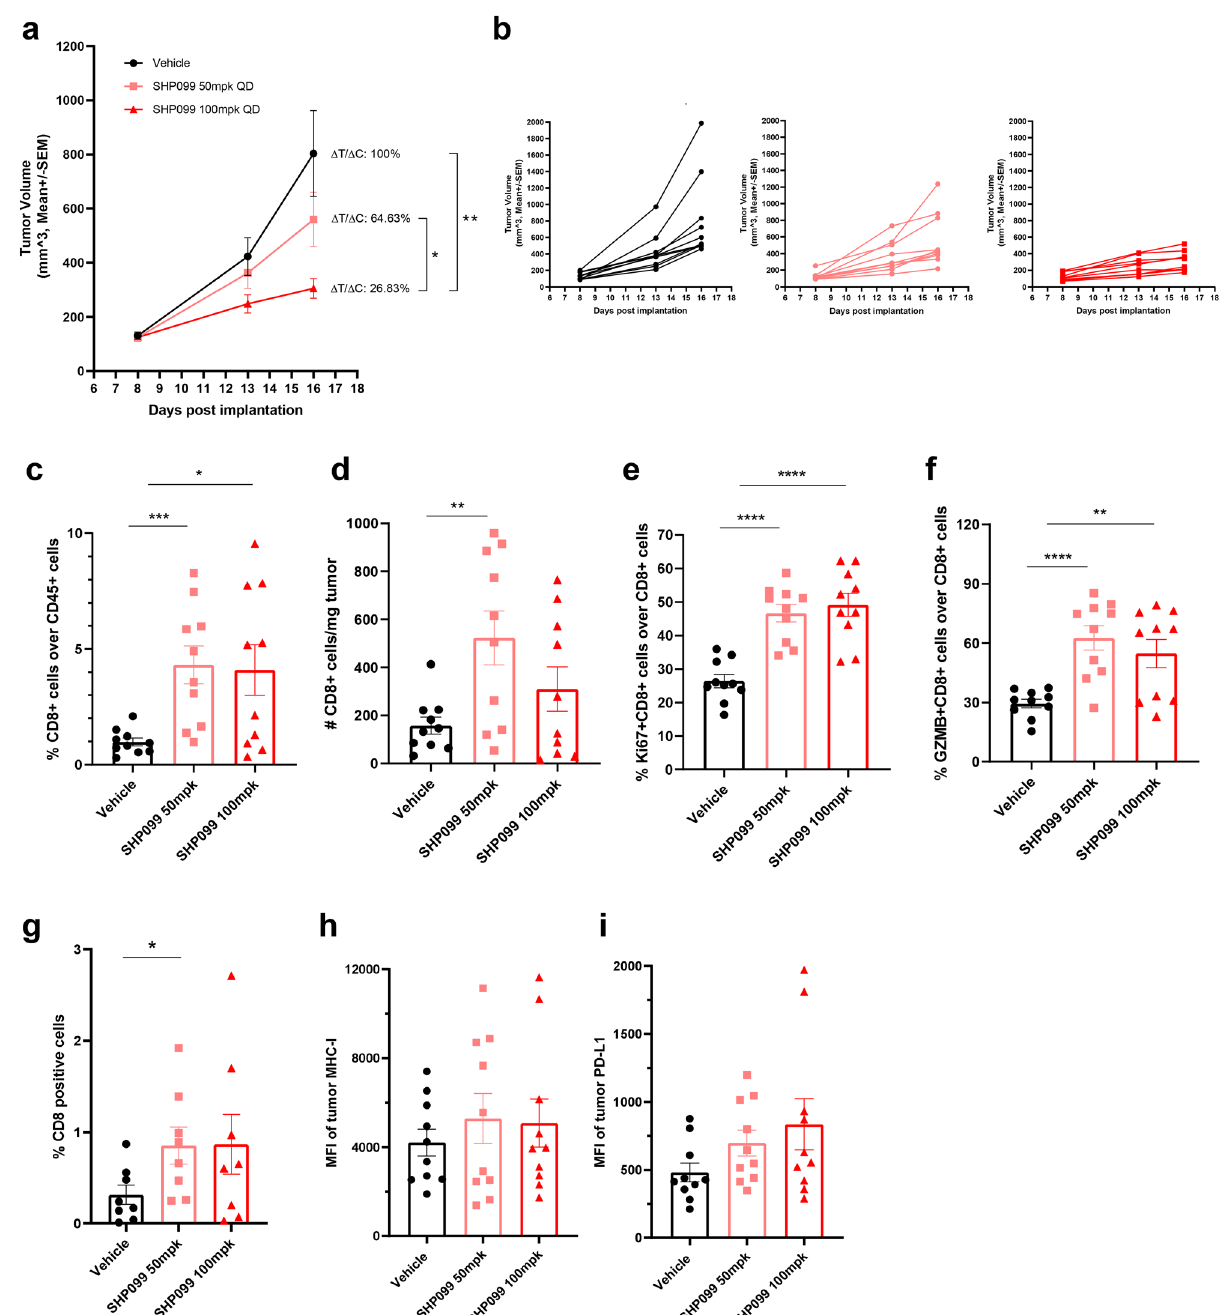
Figure 6. SHP2 inhibition decreases tumor load in the 4T1 syngeneic mice model. ( a ) Tumor growth curve (expressed as tumor volume) of subcutaneous 4T1 tumors in 4T1 syngeneic mice with different treatments. ΔT/ΔC of last time point was labeled. ( b ) Spider plot of tumor growth curve (expressed as tumor volume) of subcutaneous 4T1 tumors in 4T1 syngeneic mice with different treatments. ( c ) Flow cytometry analysis of the percentage of CD8+ T cells over CD45+ cells in tumor tissues with different treatments in 4T1 syngeneic model. ( d ) Flow cytometry analysis of the absolute number of CD8+ T cells per milligram tumor with different treatments in 4T1 syngeneic model. ( e ) Flow cytometry analysis of the percentage of Ki67+ CD8+ T cells over CD8+ cells in tumor tissues with different treatments in 4T1 syngeneic model. ( f ) Flow cytometry analysis of the percentage of GZMB+ CD8+ T cells over CD8+ cells in tumor tissues with different treatments in 4T1 syngeneic model. ( g ) IHC analysis of CD8 T cells in tumor tissues with different treatments from 4T1 syngeneic model. Y axis means the percentage of CD8+ cells over all the cells in the same slide. ( h ) MFI of the tumor surface MHC Class I with different treatments in 4T1 syngeneic model. ( i ) MFI of the tumor surface PD-L1 with different treatments in 4T1 syngeneic model. Flow cytometry data was analyzed and processed with FlowJo (Version 10.7.1, https ://www.flowj o.com/solut ions/flowj o/downl oads/previ ous-versi